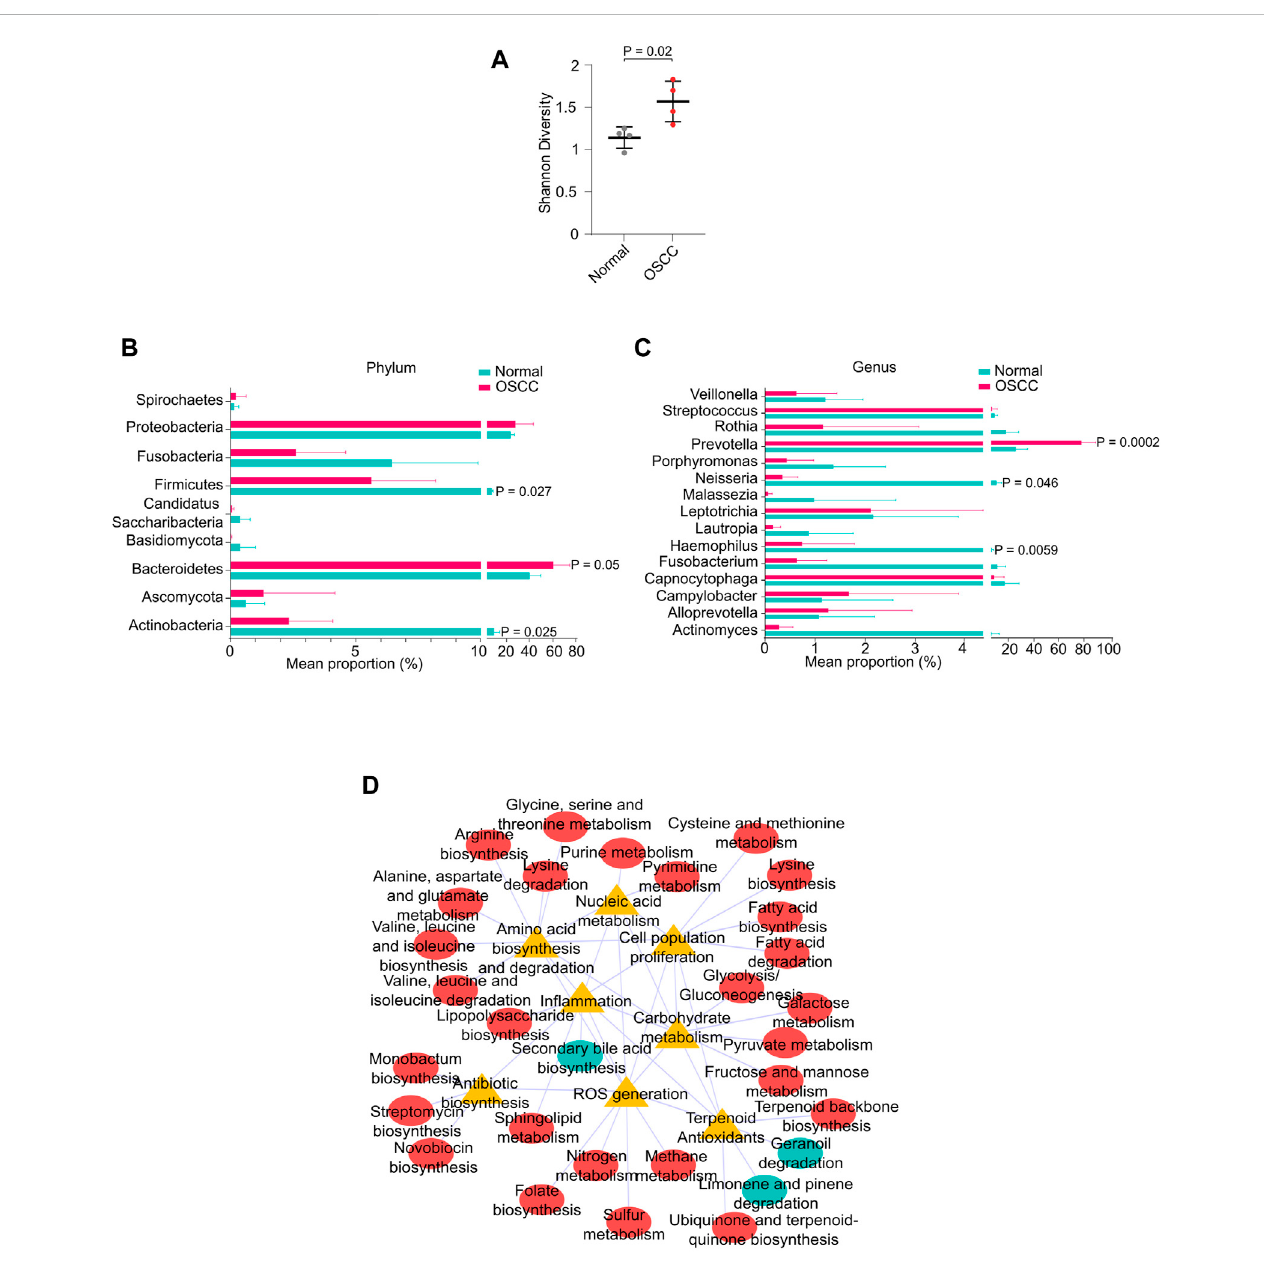
FIGURE 4 Oral microbial dysbiosis in OSCC. (A) Shannon diversity index showing microbial diversity between normal and OSCC. Mean proportion of microbial phyla (B) or genus (C) between normal and OSCC. (D) Interaction network between metabolic pathways and functional